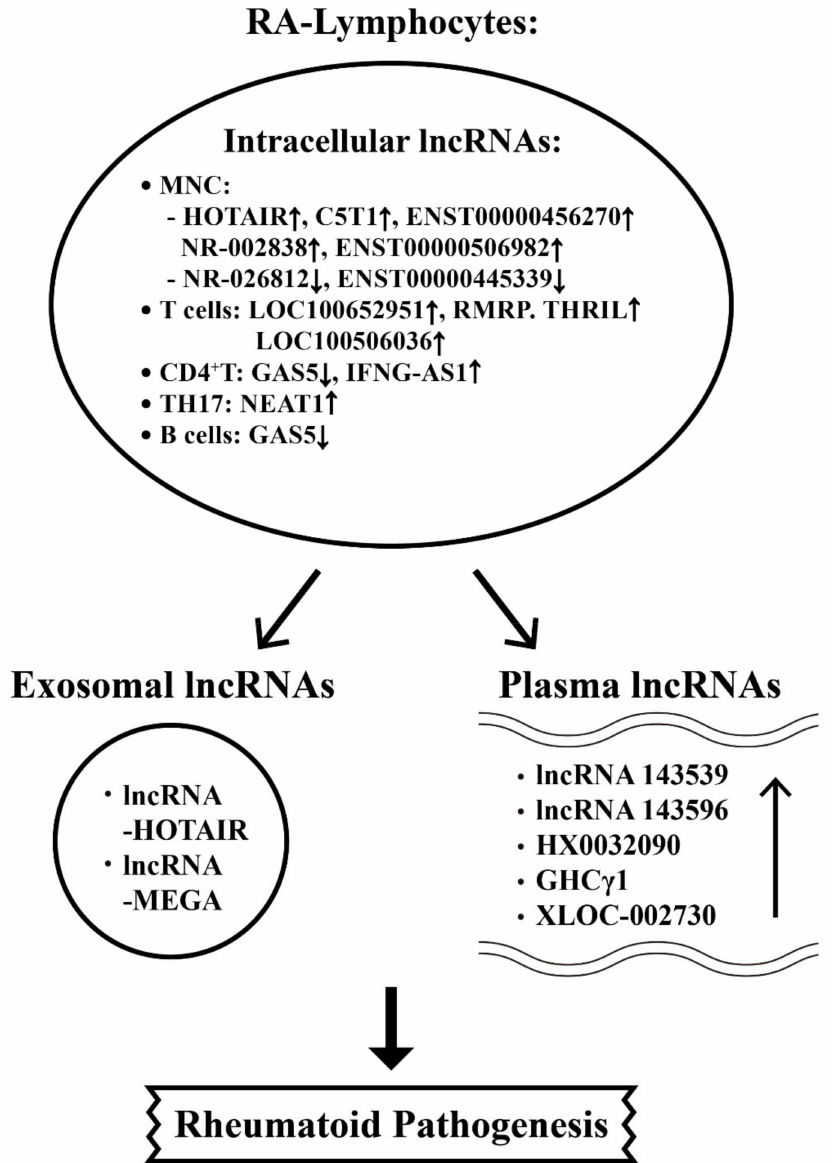
Figure 5. The involvement of intracellular long non-coding RNAs (lncRNAs) in the T and B cell differentiation and T cell release of exosomal and plasma miRs during the development of RA. The immune cell subpopulations include CD4 + T, Th17, and B cell. ↑ : Increase, ↓ : Decrease. 7. The Effects of Rheumatoid Inflammation-Induced Aberrant Non-Coding